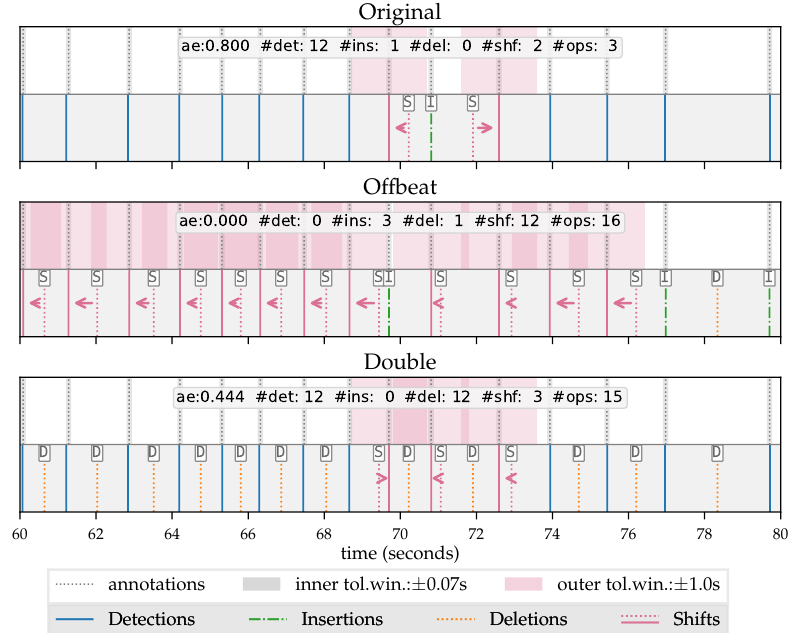
Figure 3. Visualisation of the operations required to transform beat detections to maximise the F-measure when compared to the ground truth annotations for the period from 60–80s, of Evocaciòn . (Top) Original beat detections vs. ground truth annotations. (Middle) Offbeat —180 degrees out of phase from the original beat locations—variation of beat detections vs. ground truth annotations. (Bottom) Double —beats at two times the original tempo—beat detections vs. ground truth annotations. The inner tolerance window is overlaid on all annotations, whereas the outer tolerance window is only shown for those detections to be